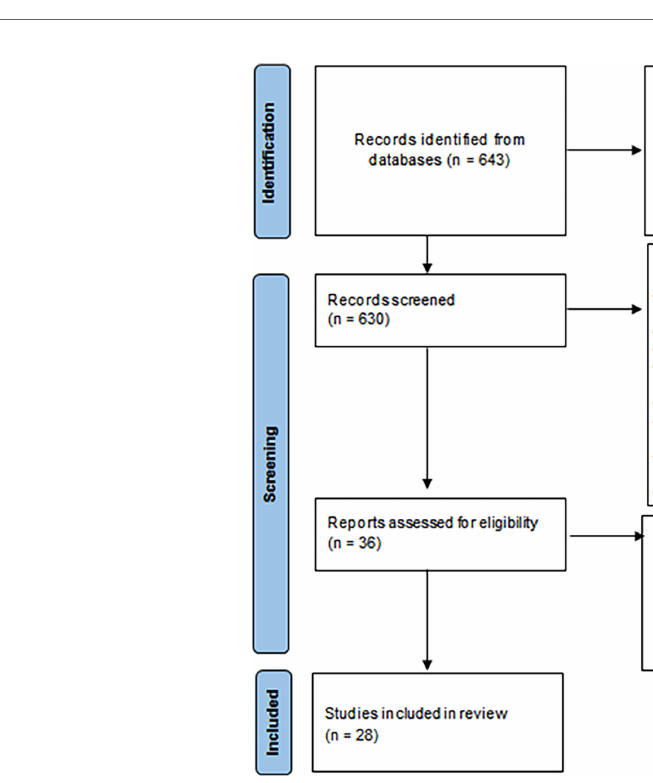
( Table 3 ). Most of the papers used one of two different protocols of inducing MIA, either utilising an intraperitoneal (i.p.) injection of 20 mg/kg of poly(I:C), or an injection of 0.05 mg/kg of LPS, at embryonic day (E) 12.5. One study used a subcutaneous osmotic pump releasing IL-17 at a rate of 0.025